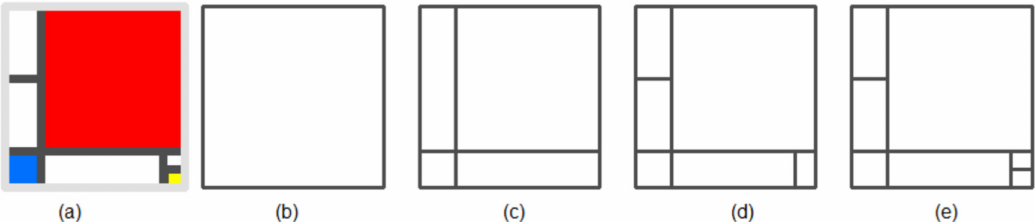
Figure 6. Composition II by Piet Mondrian ( a ) and its evolution from the empty square. (Note: It